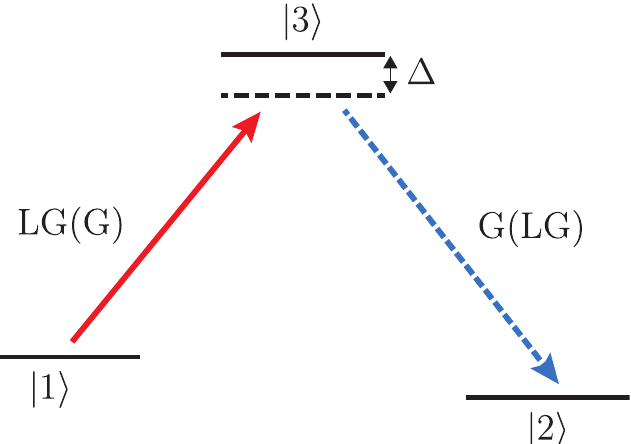
Figure 1. Schematic of the electronic states considered, in a Λ configuration. Specifically, the states of interest are | 1 (cid:105) and | 2 (cid:105) which represent the states associated with the two-component Bose–Einstein Condensate (BEC). These two states are coupled, via | 3 (cid:105) , through detuned Guassian (G) and Laguerre– Gaussian (LG) laser pulses. In this work two laser pulse sequences are considered: (i) G-LG where the Gaussian is the pulse ( | 1 (cid:105) → | 3 (cid:105) ) beam and the Laguerre–Gaussian is the Stokes ( | 3 (cid:105) → | 2 (cid:105) ) beam and (ii) LG-G where the Laguerre–Gaussian is the pulse ( | 1 (cid:105) → | 3 (cid:105) ) beam and the Gaussian is the Stokes ( | 3 (cid:105) → | 2 (cid:105) )